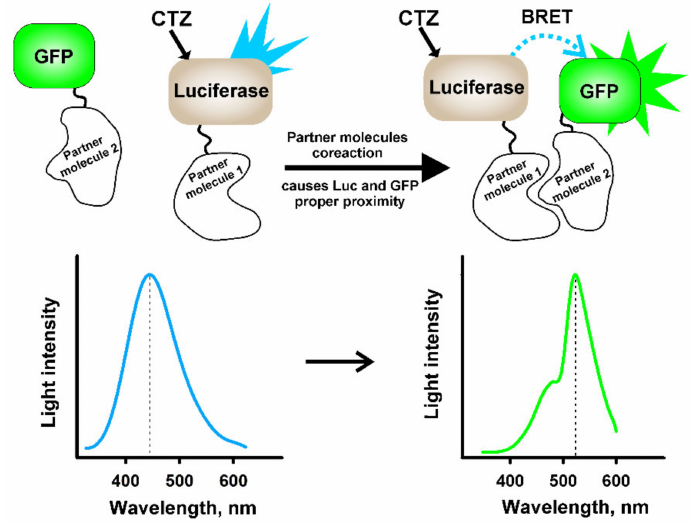
Figure 5. General principle of the BRET-based analytical